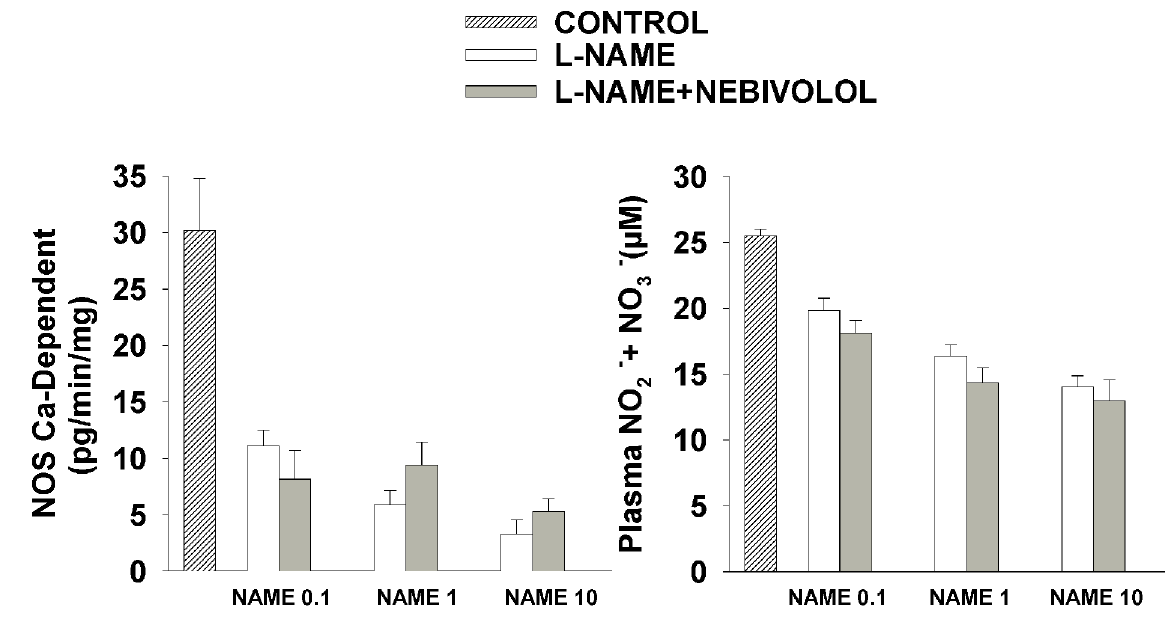
FIGURE 5 . Renal calcium-dependent nitric oxide synthase (NOS) activity (left) and plasma nitrates+nitrites (right) in the experimental groups after 2 weeks of